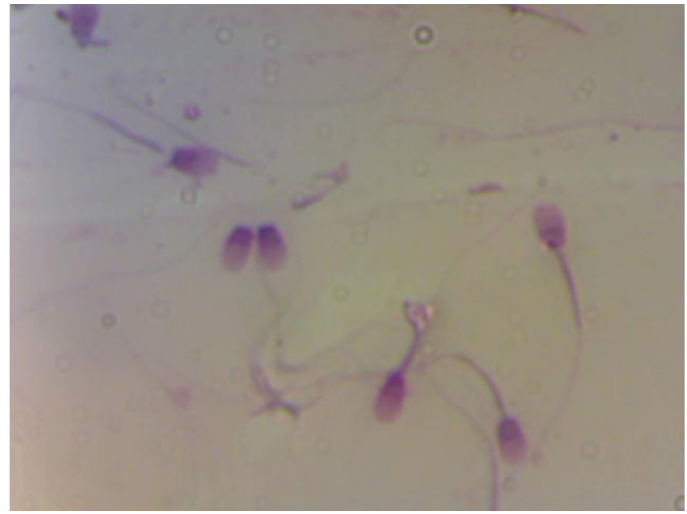
figure 3. Morphological evaluation of